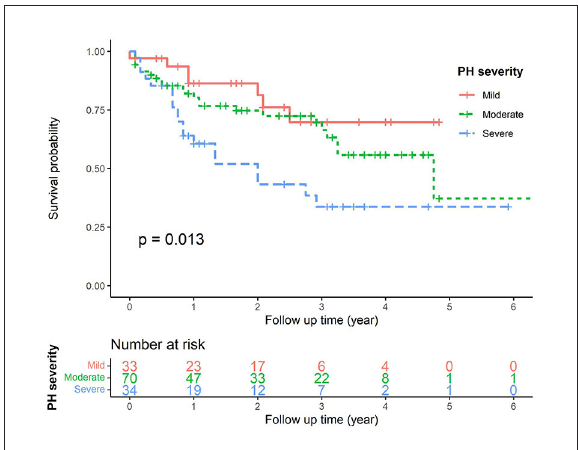
FIGURE4 The Kaplan–Meier curves for CKD patients with different PH severity. p <